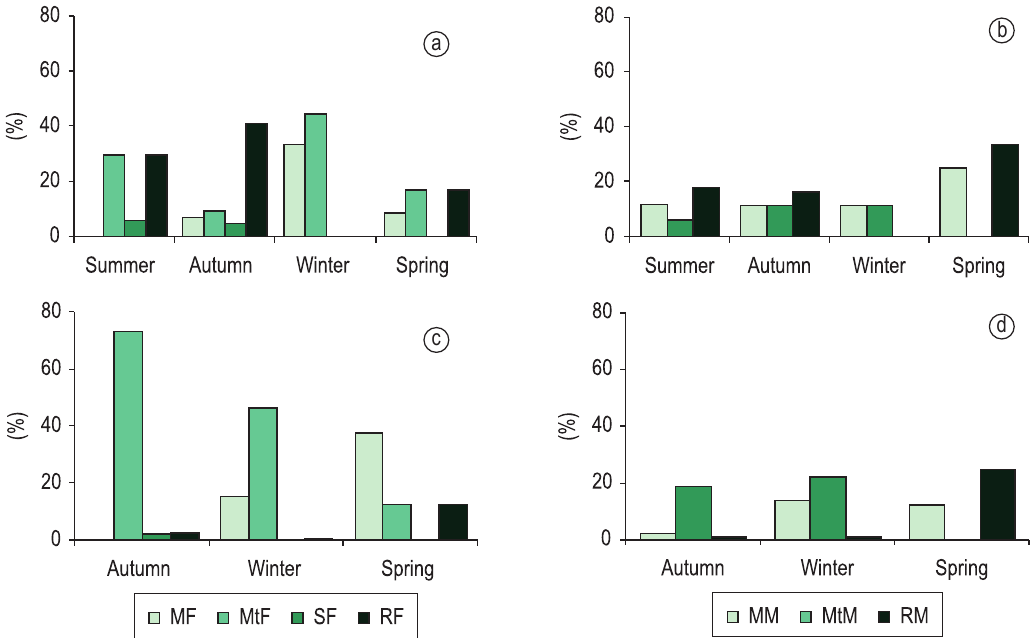
Figure 3. Percentage distribution of gonadal development stage of A. fasciatus . a,b) High Basin; c,d) Middle Basin. MF: Maturing Female, MtF: Mature Female, SF: Spawning Female, RF: Resting Female, MM: Maturing Male, MtM: Mature Male, RM: Resting Male.